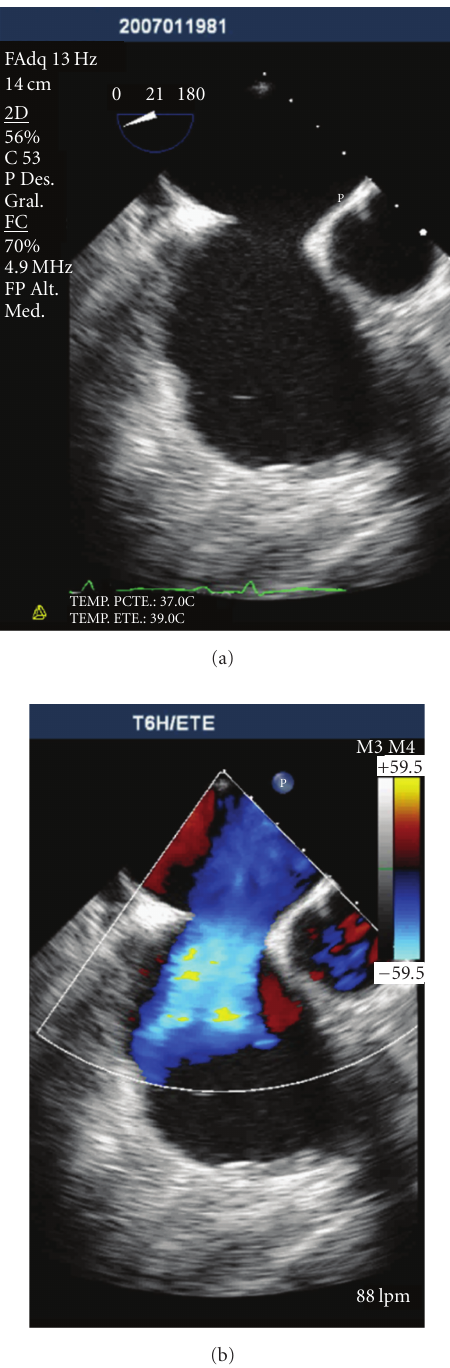
Figure 2: Transesophageal echocardiography showing interatrial communication with severe (a)–(b)